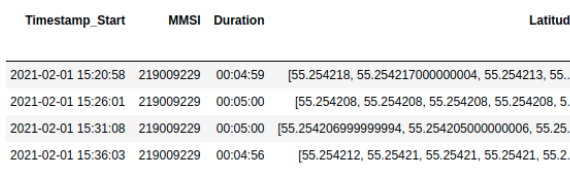
Figure 4 . Resulting resampled data (4 fragments) from example above